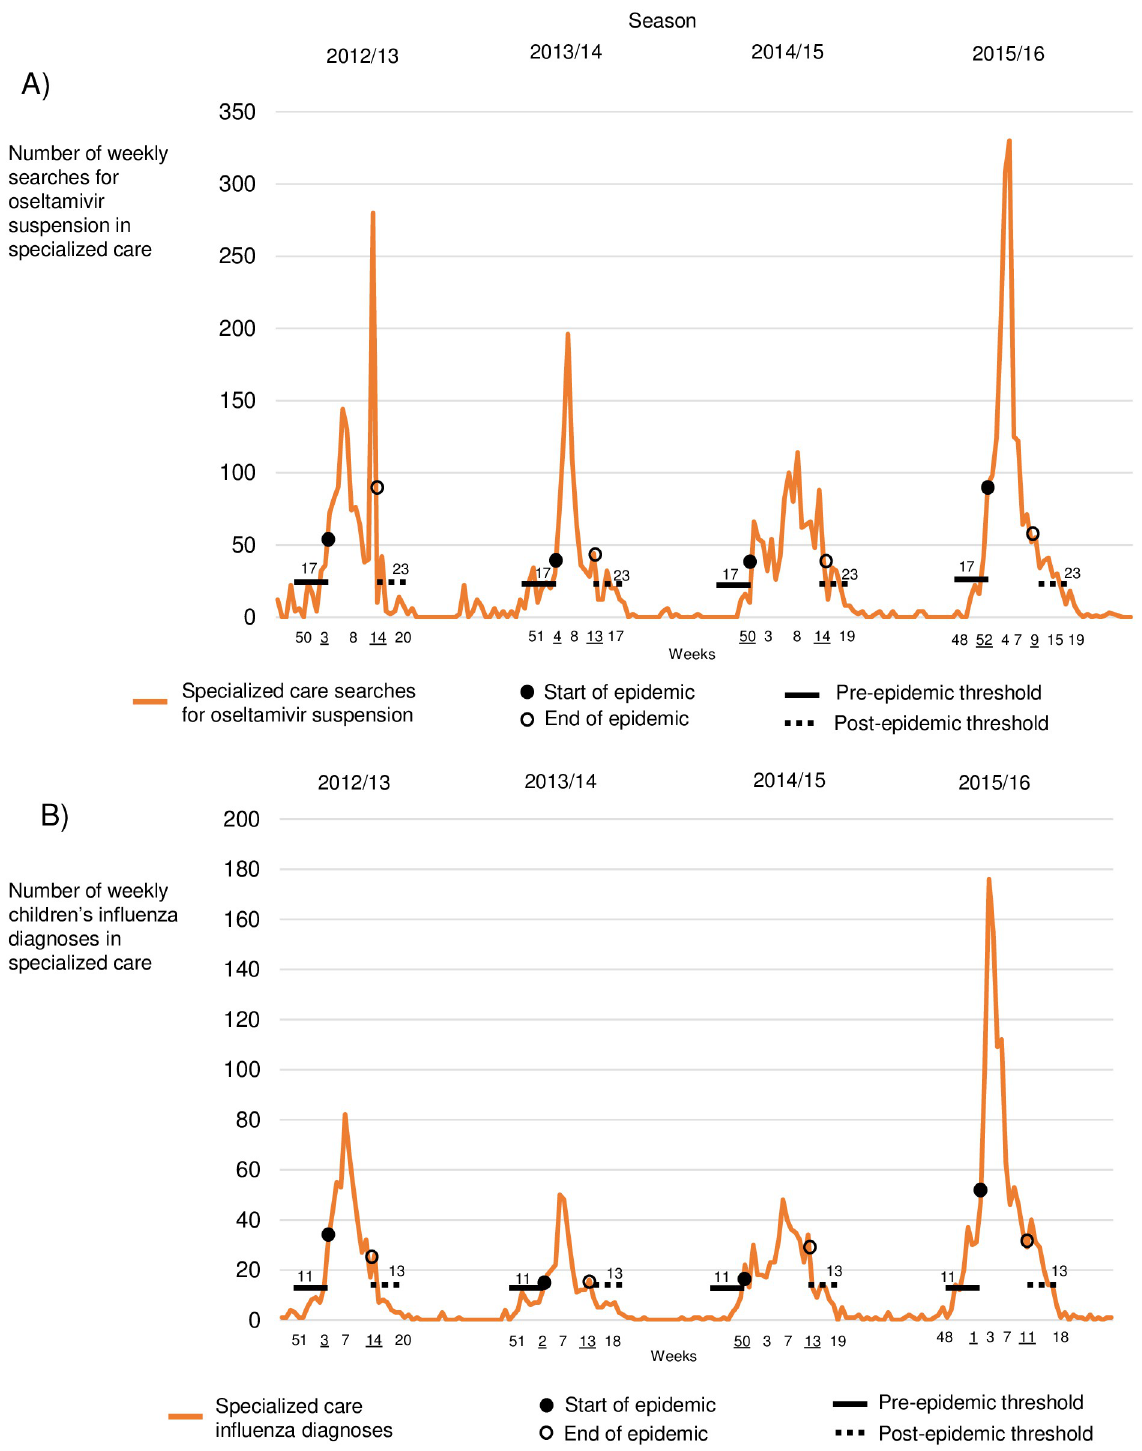
Fig 3. Specialized care searches, diagnoses, and starts and ends of influenza epidemic periods (underlined weeks) across Finland during 2012–2016 by season, including pre-epidemic and post-epidemic influenza thresholds. (A) Weekly searches for oseltamivir suspension in specialized care. (B) Weekly children’s influenza diagnoses in specialized care.